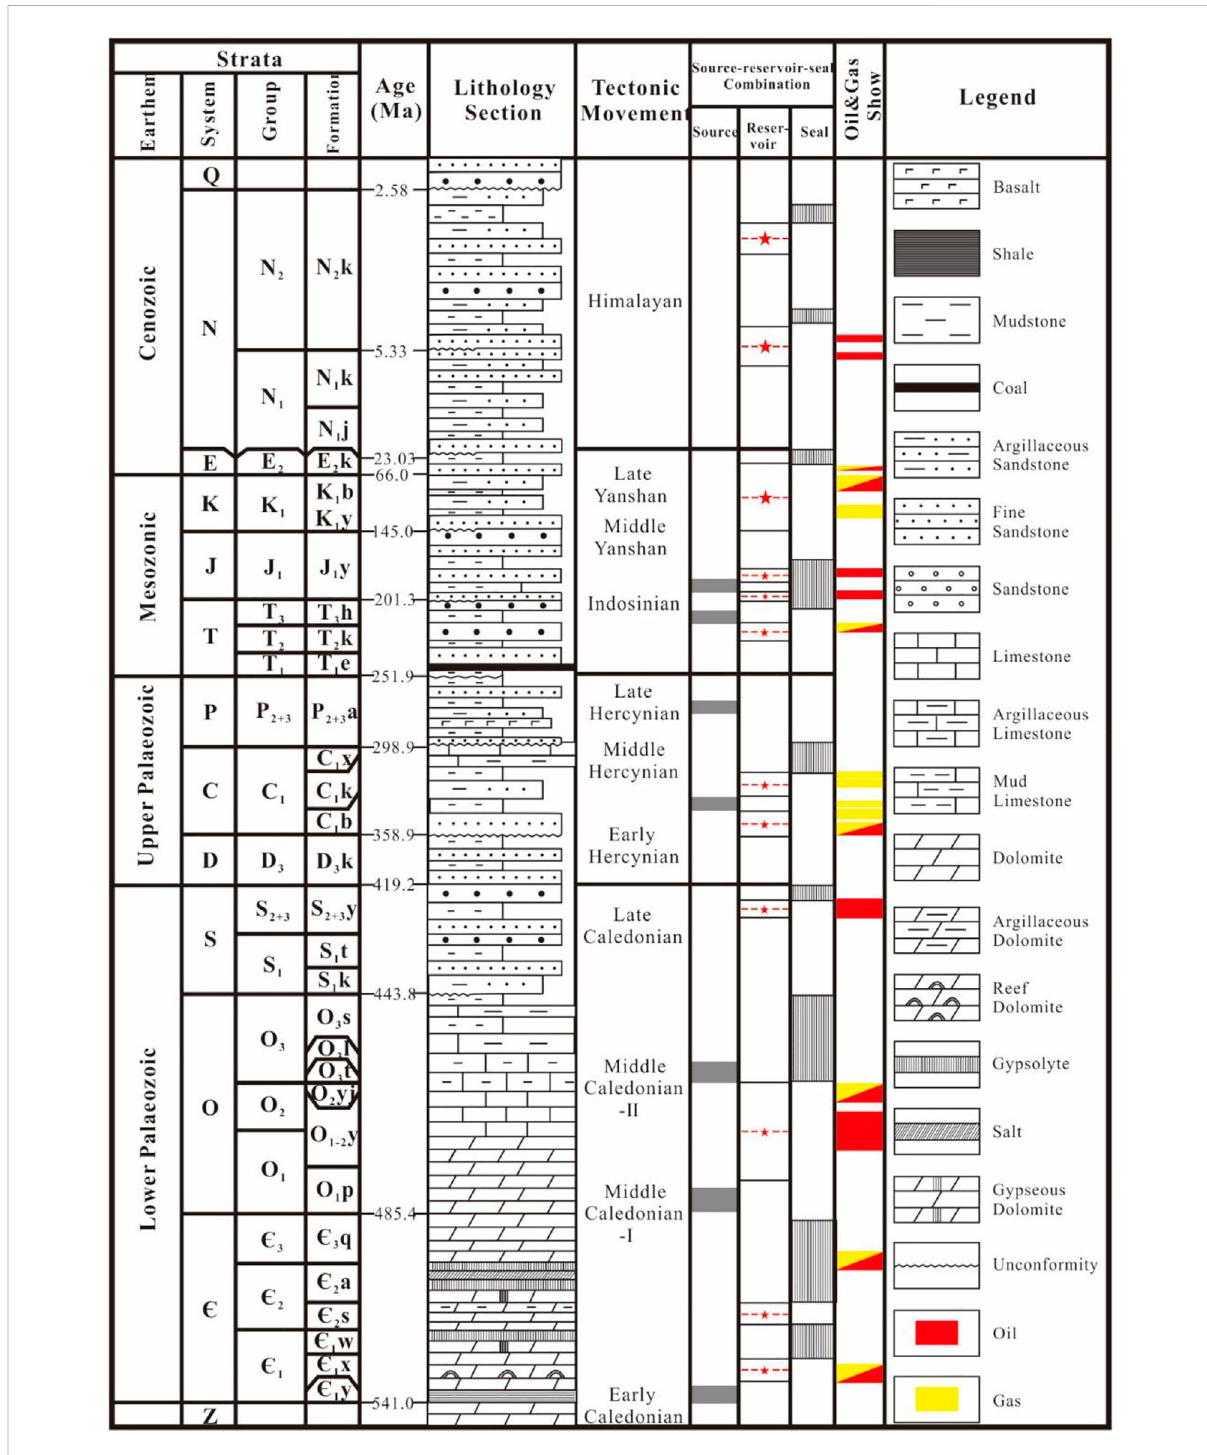
FIGURE 2 Generalized chart showing stratigraphy, lithology, tectonicevolution, andpetroleum system elements of the Tarim Basin(modi fi edfrom Zhu et al.,